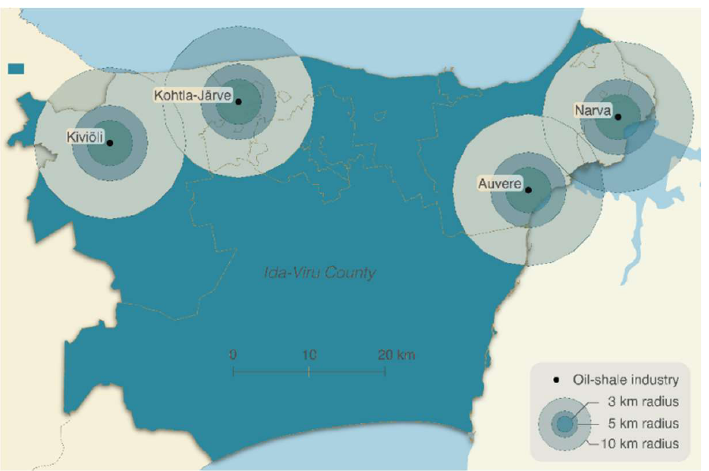
Figure 2. Oil shale industries in Ida-Viru County and 3 km, 5 km, and 10 km buffers around them. Basemap: © Land